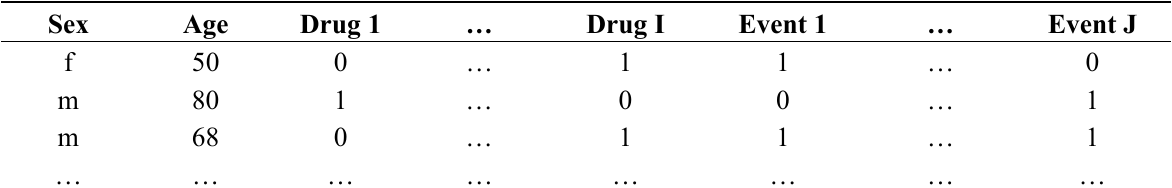
Table 1. Exemplary structure of data derived from spontaneous reports. The reports were processed to drug-event combinations on subject level (0 = no event/exposure reported, 1 = event/exposure